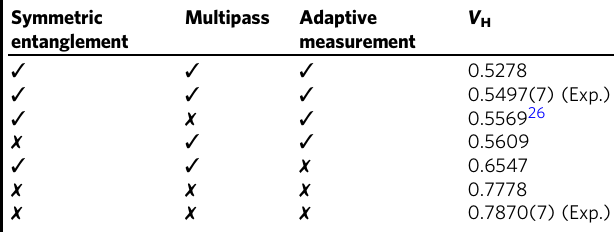
Table 2 The Holevo variance for different schemes Symmetric